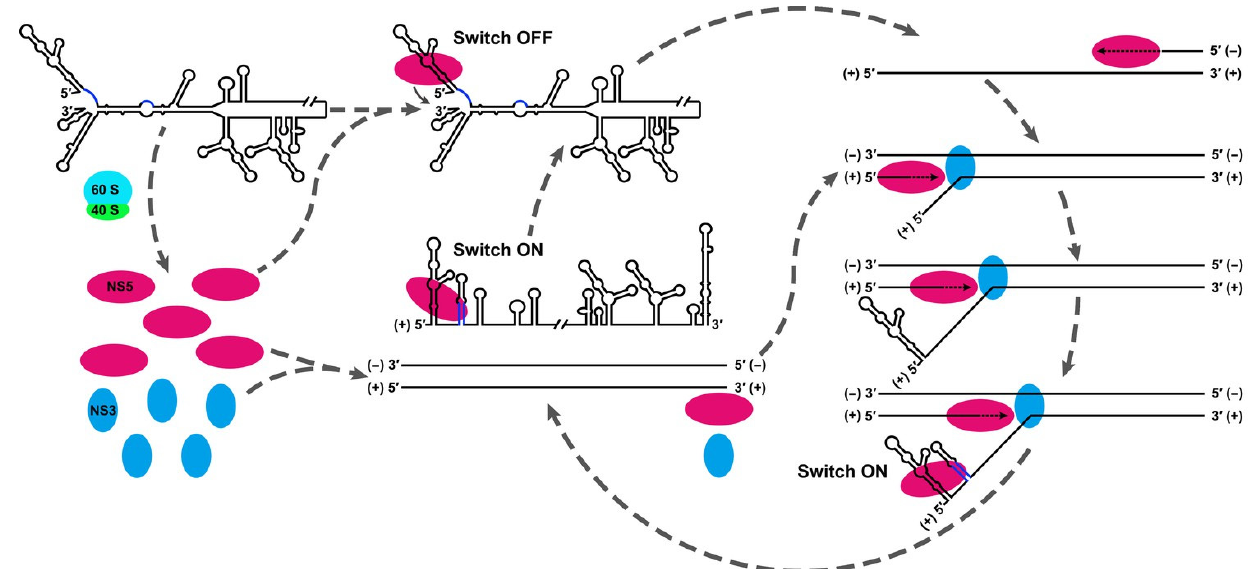
Figure 3. Schematic model elucidating the functional mechanism of the UAR-flanking stem (UFS) switch. Genome cyclization is crucial for the non-structural protein 5 (NS5) translocation to the RNA synthesis initiation site. Adapted with permission from [66].